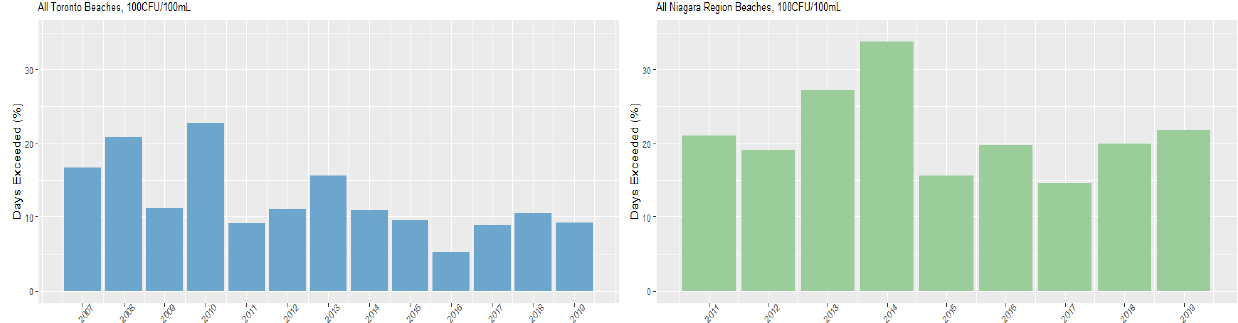
Figure 4. Annual E. coli threshold exceedances—100 CFU/100 mL.